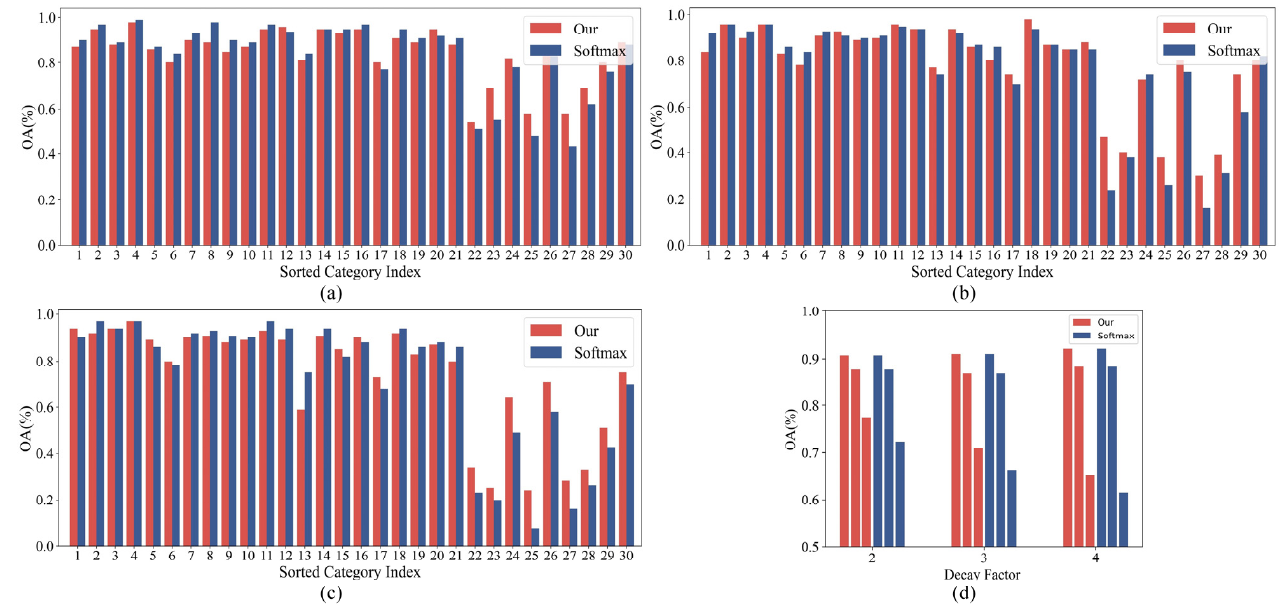
Figure 10. ( a – c ) show the classification accuracy of the proposed method and Softmax cross ‐ entropy method for samples from each category in the long ‐ tailed AID dataset with decay factors of 2, 3, and 4, respectively. ( d ) shows the average classification accuracy of the proposed method and the Softmax cross ‐ entropy method on the long ‐ tail AID dataset with decay factors of 2, 3, and 4 for the head categories, middle categories, and tail categories, respectively.